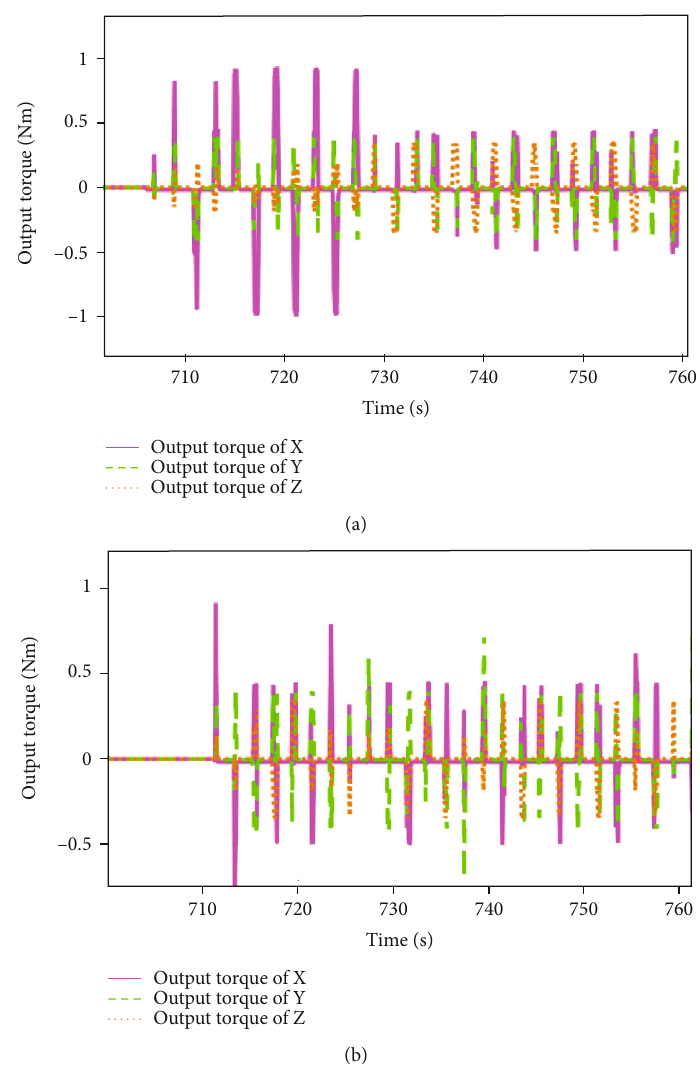
Figure 10: Output torque of propulsion system. (a) PD control. (b) Neural network sliding mode control.